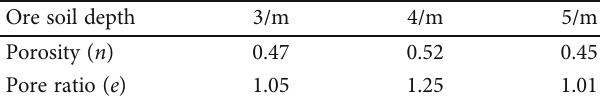
Table 3: Porosity and pore ratio of ore samples at di ff erent depths.